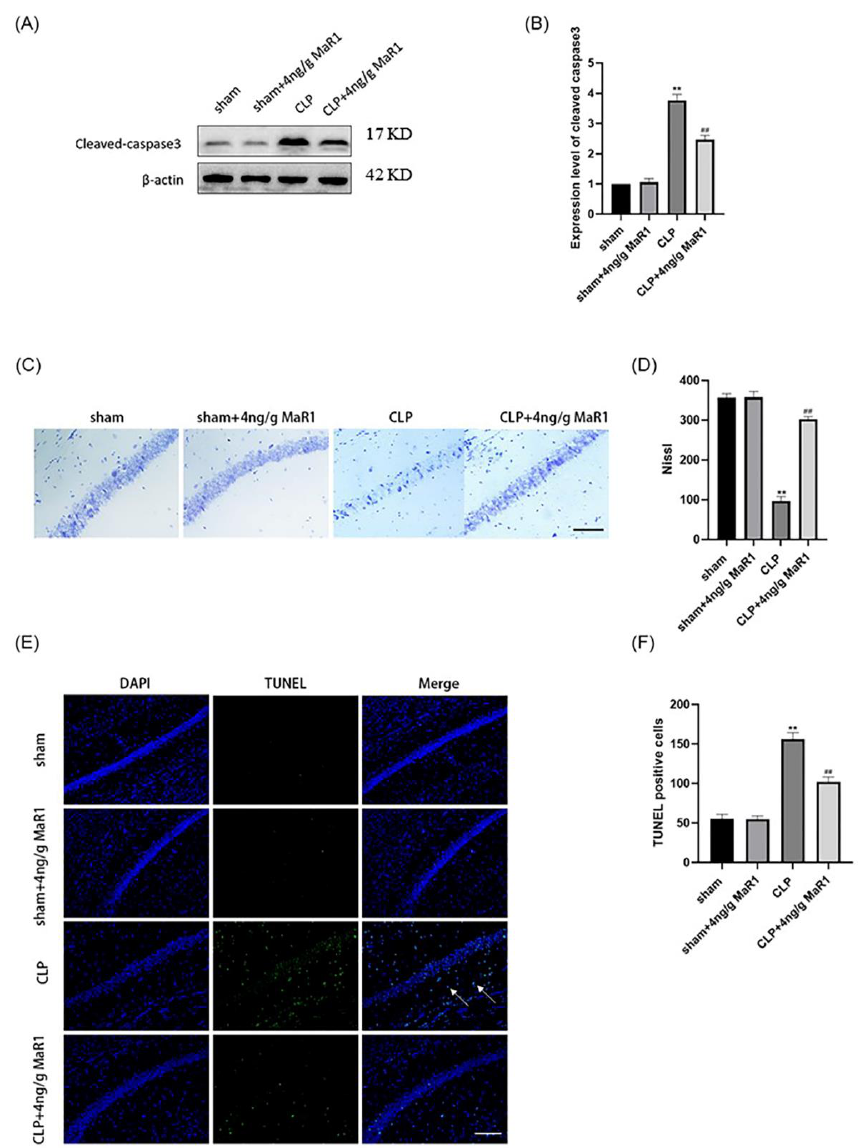
Figure 4. 4 ng/g of MaR1 treatment prevents neuronal apoptosis in CLP rats: ( A , B ) protein expression levels of cleaved-caspase3 in the hippocampus of CLP rats; ( C , D ) nissl staining analysis of neuronal morphology and the number of normal neurons in the hippocampus of CLP rats, bar = 50 μm; ( E , F ) quantitative analysis of TUNEL-positive cells in the hippocampus of CLP rats by TUNEL staining, bar = 50 μm; ** p < 0.01, compared to the Sham group; ## p < 0.01, compared to the CLP group.